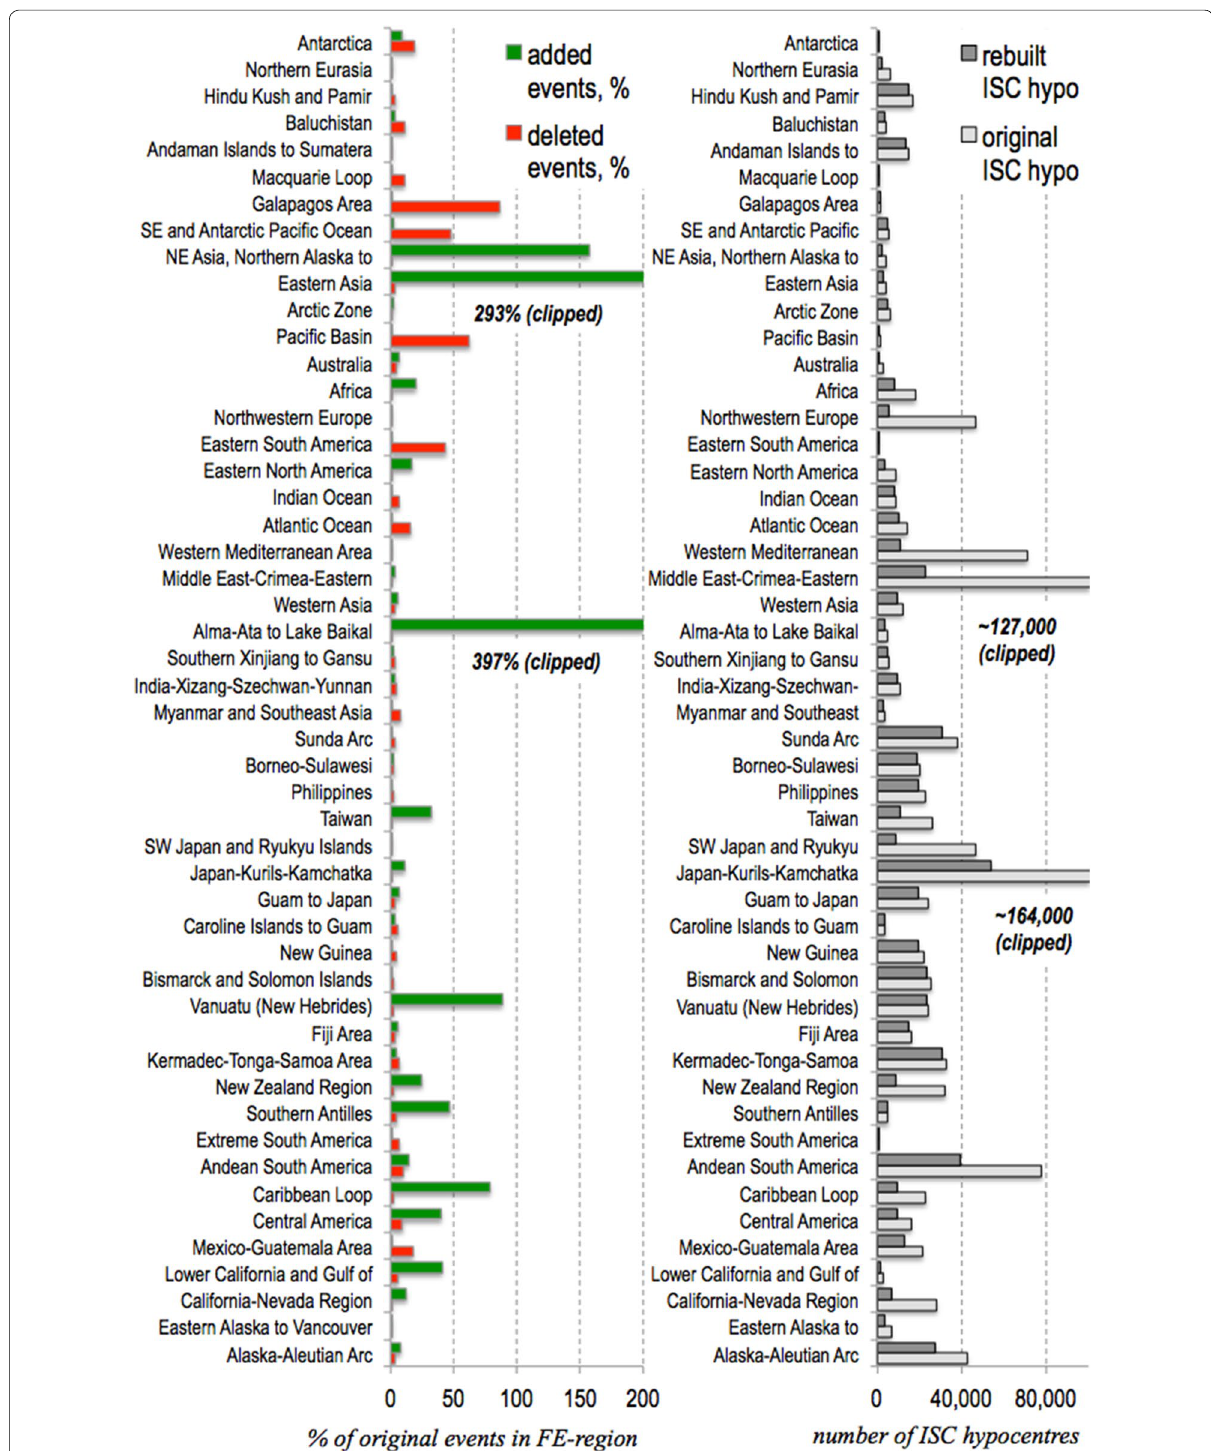
Fig. 10 Regional distribution (FE—Flinn and Engdahl, 1974; Young et al., 1996) of seismic events deleted and added to the ISC Bulletin (left) and the FE-distribution of the ISC hypocentres in the original and rebuilt ISC Bulletins